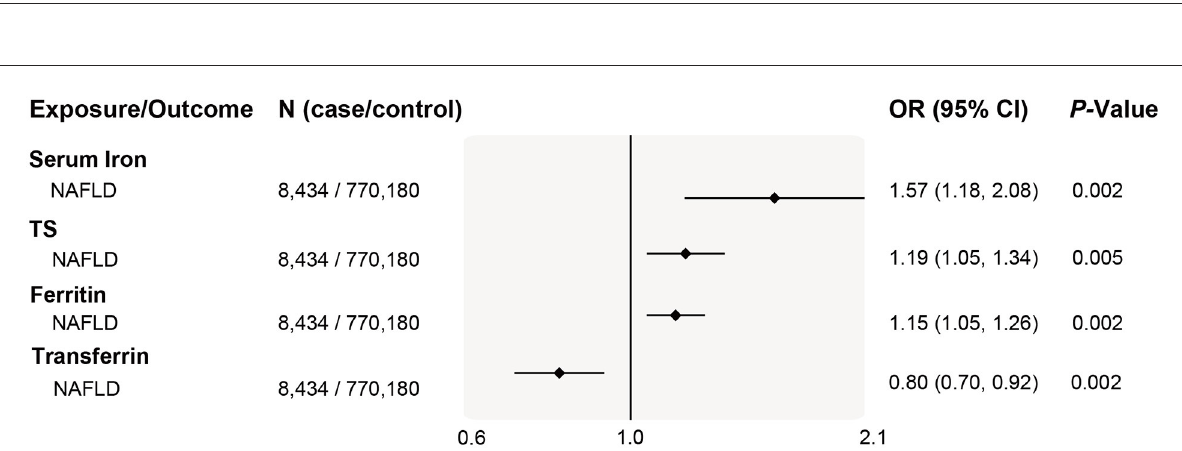
FIGURE5 Replication of associations of genetically predicted iron status and NAFLD in the largest NAFLD GWAS study. The ORs (95% CI) of NAFLD per SD increase of iron status biomarkers were estimated using a fixed-effect inverse-variance weighted meta-analysis. OR, odds ratio; 95% CI, 95% confidence interval; NAFLD, nonalcoholic fatty liver disease; SD, standard